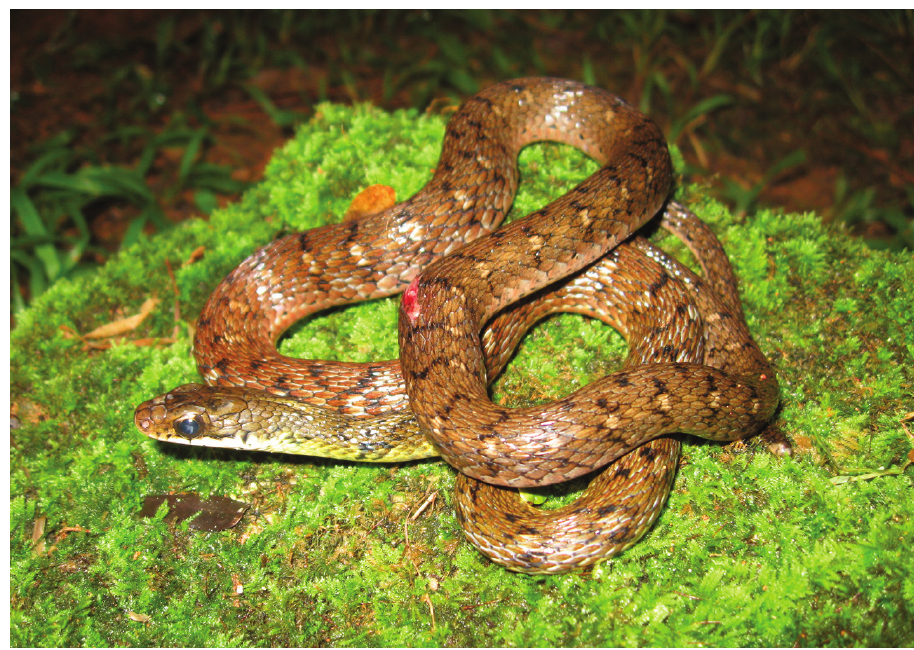
Figure 74. Tropidonophis dendrophiops (KU 319996) from Mt. Magdiwata, Barangay Bayugan II, Mu- nicipality of San Francisco, Agusan del Sur Province. Photo: